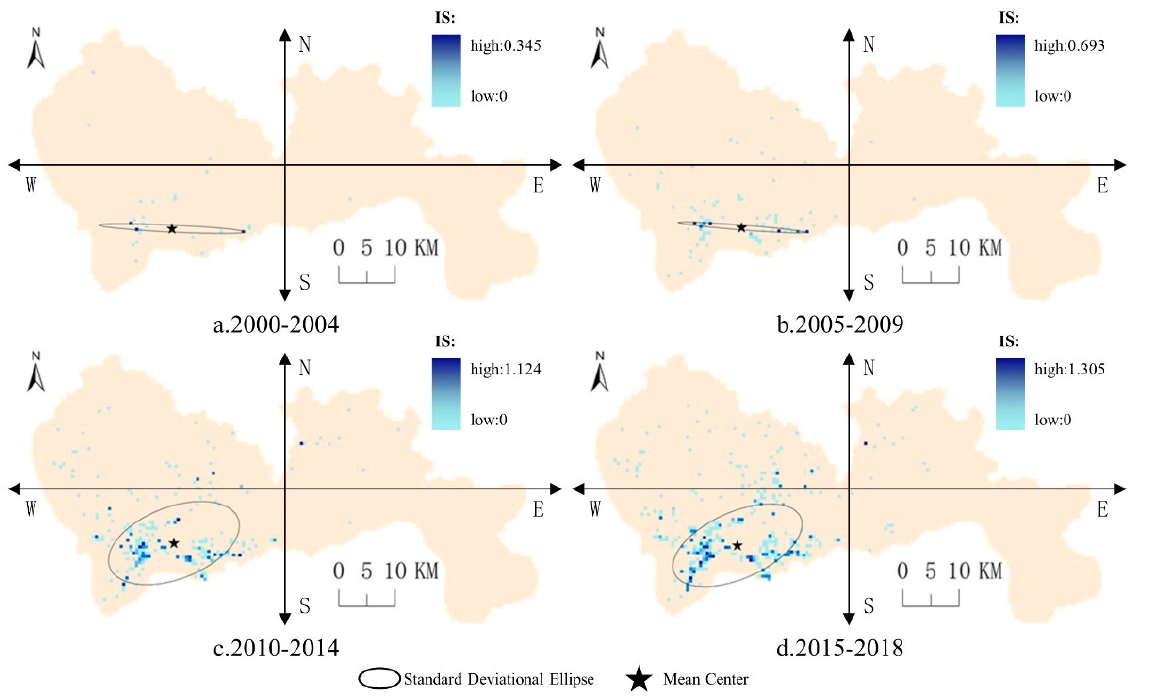
Figure 11. Spatial distribution of the innovation structure of the tertiary industry in Shenzhen.